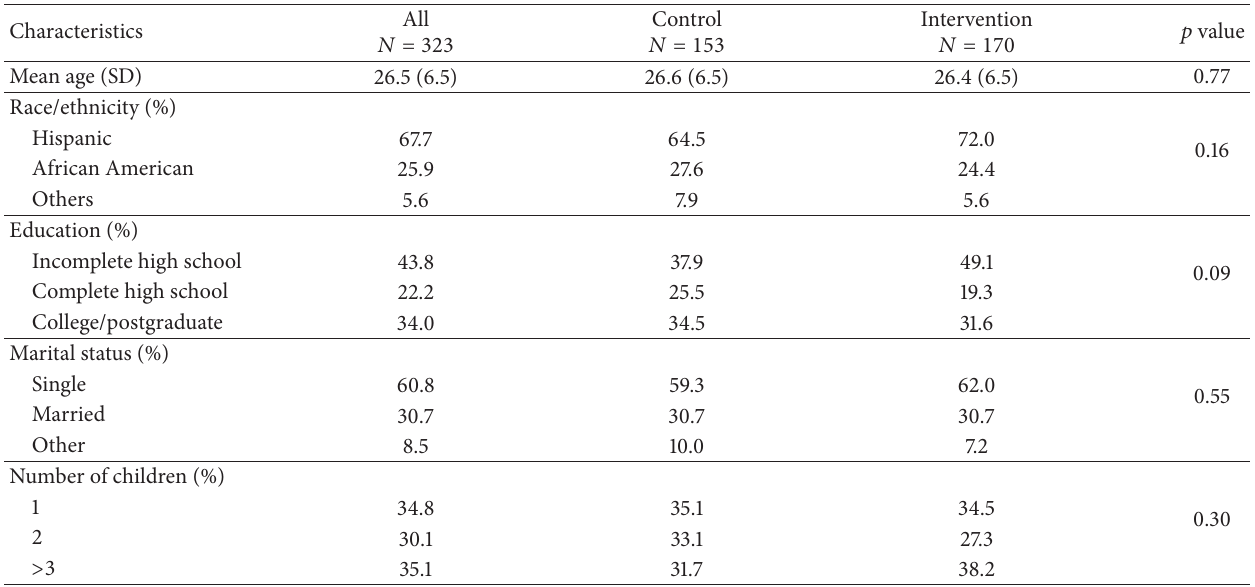
Table 1: Demographic characteristics of all participants in each study